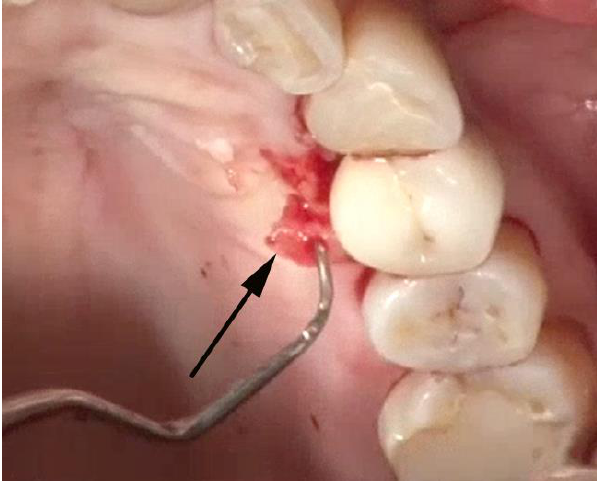
Figure 7. A thin (1–2 mm) section of tissue (arrow) containing foreign particles of titanium or cement is removed from the area of bone loss.